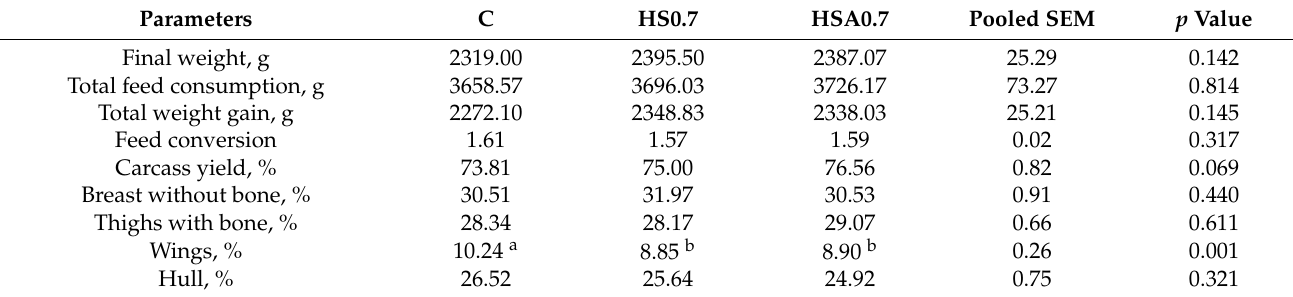
Table 3. The results of the growth performance and carcass yield of broilers.